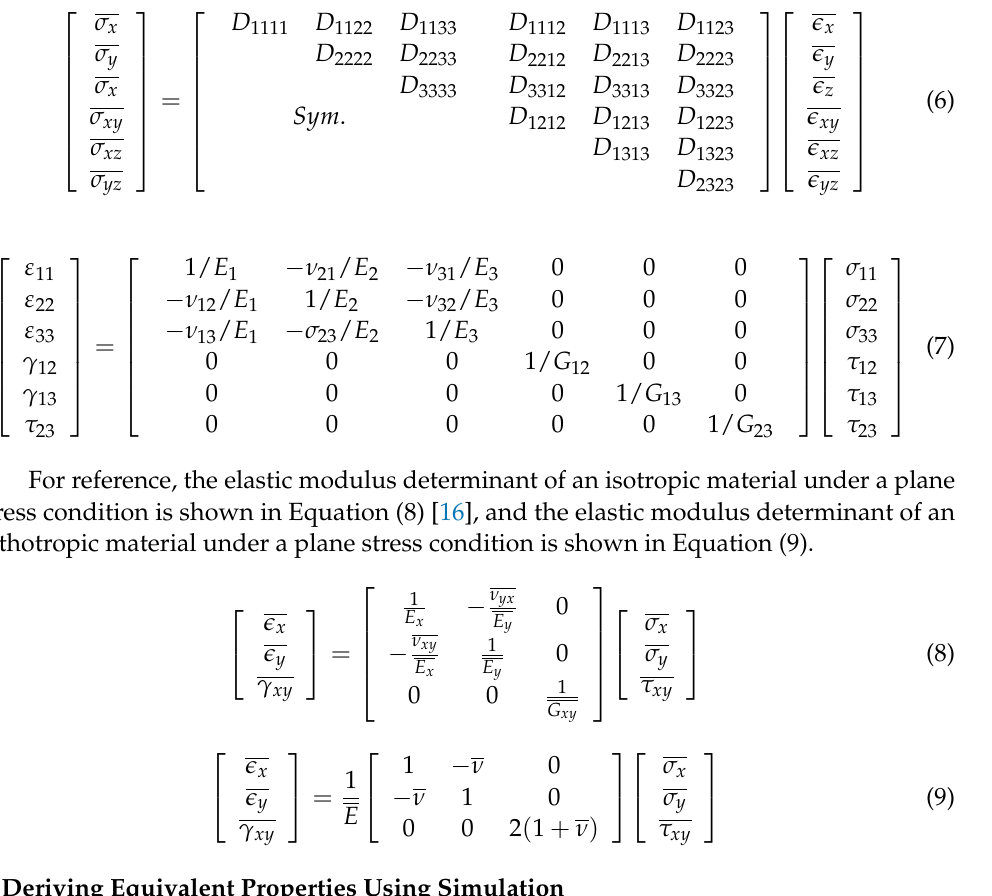
and elliptical shapes were selected for ease of processing of a material